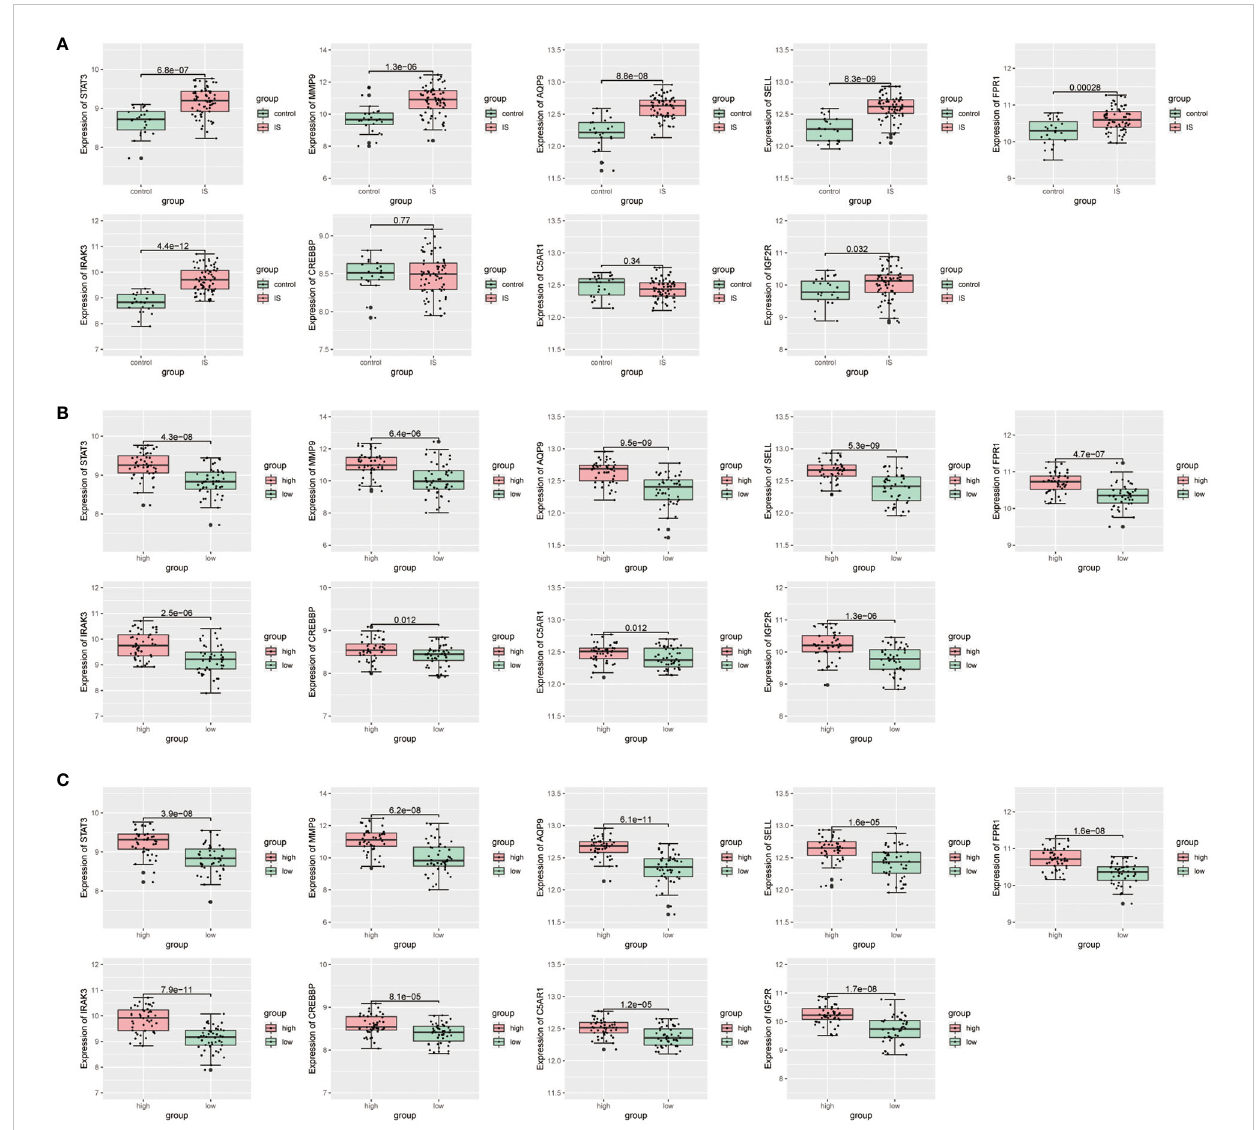
FIGURE 5 Validation for differential expression of candidate critical genes using GSE58294 dataset between (A) IS and control groups, (B) oxidative stress-high and oxidative stress-low groups, (C) neutrophil-high and neutrophil-low groups,